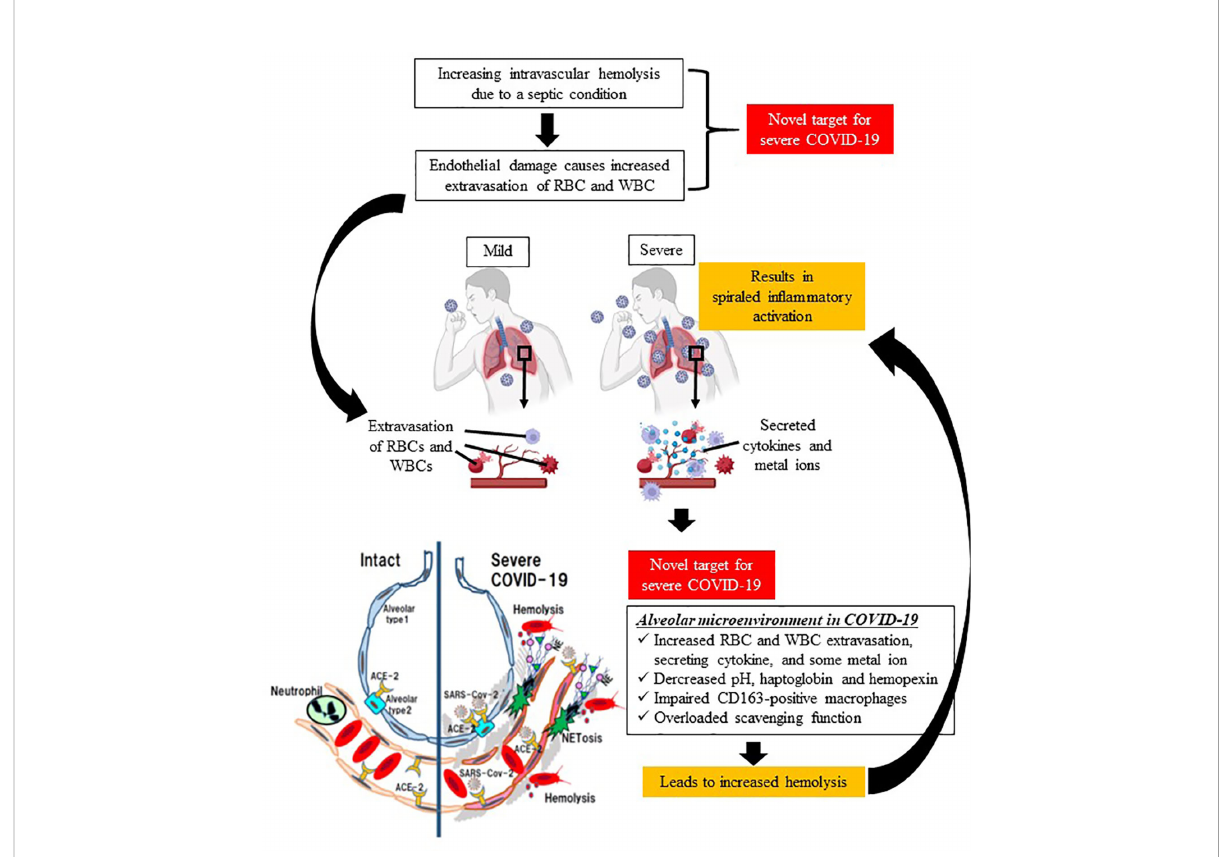
FIGURE 1 Schematic diagram of spiraled in fl ammatory activation and tissue damage by hemolysis in severe COVID-19. Sepsis causes intravascular hemolysis by many mechanisms (e.g., microvasculitis, complement activation, glucose metabolism, and eryptosis), leading to increased vascular permeability, and thereby extravasation of both red blood cells and immune system cells. The fi rst target in the proposed treatment strategy is a decrease in intravascular hemolysis. In terms of the alveolar microenvironment, increases in extravasated cells, cytokines, and metal ions deteriorate hemolysis in the extracellular space, which is associated with spiraled in fl ammatory activation in lung issue. Therefore, the second therapeutic target is a decrease in extravascular hemolysis. (This fi gure was created at